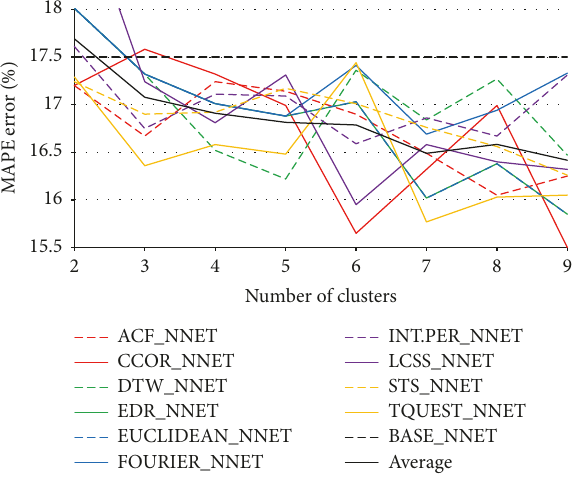
Figure 5: MAPE errors for NNET with respect to the number of clusters and the similarity